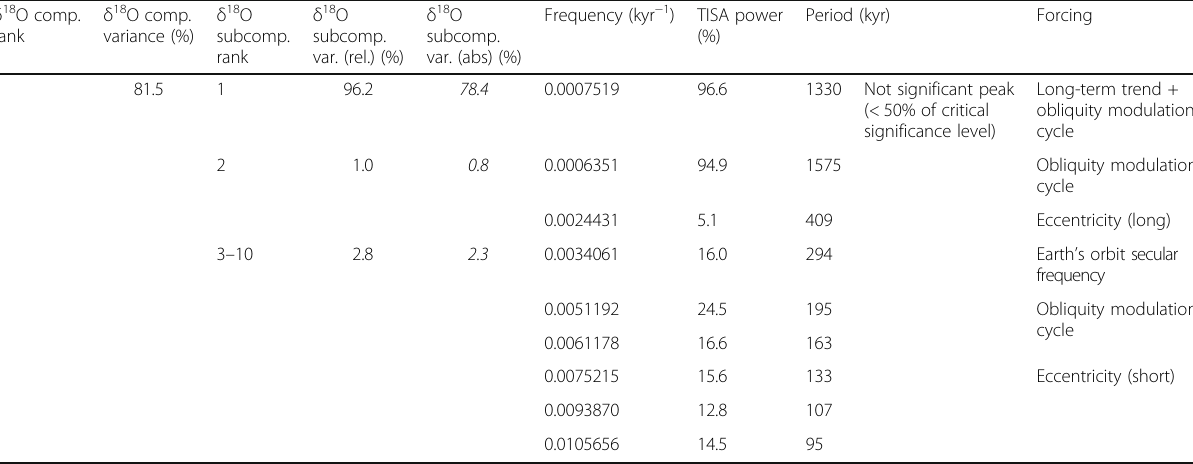
Table 2 Descriptive parameters and Fourier frequency results of the δ 18 O subcomponents isolated from the LR04 component-1 by singular spectrum analysis. The processing of the subcomponents was conducted to better separate and estimate the variance fraction of specific frequency bands from still complex data components. The italicized percentage values are the absolute variance of the subcomponents (referred to the total LR04 variance) δ 18 O comp.